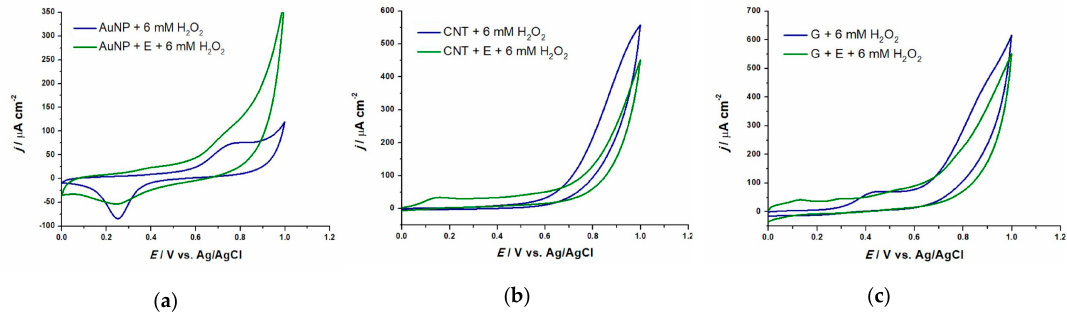
Figure 1. CV in 0.1 M NaPB, pH 7.0, in the presence and absence of the extract (E), with 6 mM H 2 O 2 addition, v = 50 mV s − 1 for: ( a ) AuNP, ( b ) CNT and ( c ) graphene (G).